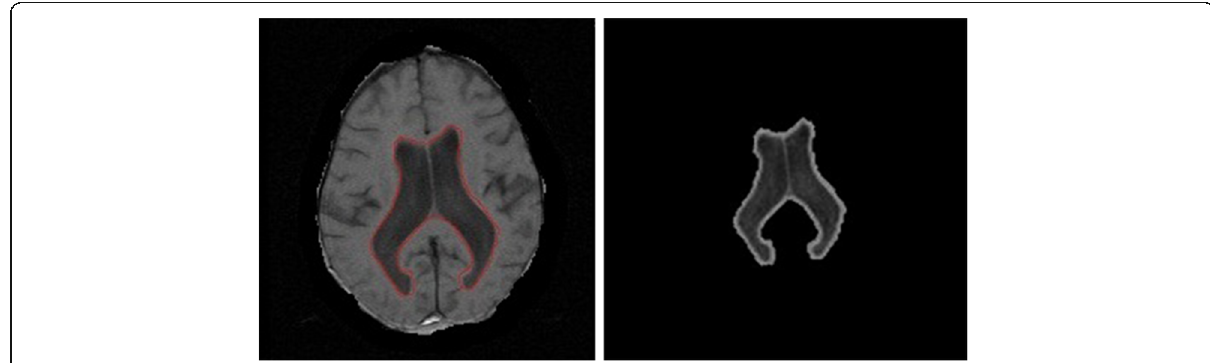
Fig. 4 Resultant images of segmentation using the proposed method with optimized parameters. With the regional information, the proposed method evolves to the actual boundary of the